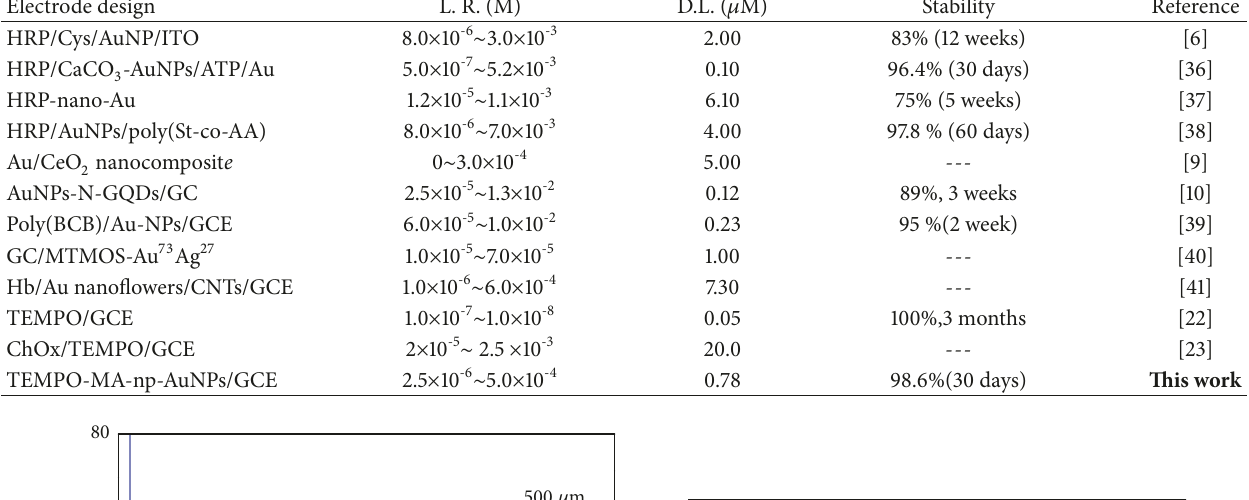
Table 1: Comparison of recent Au nanomaterials and nitroxide derivatives for H 2 O 2 detection.